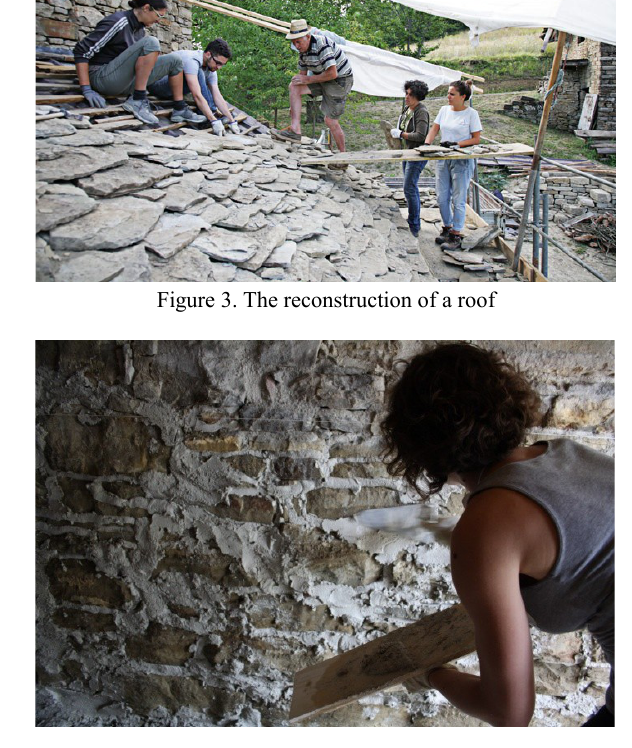
Figure 4. Use of natural hydraulic lime plasters